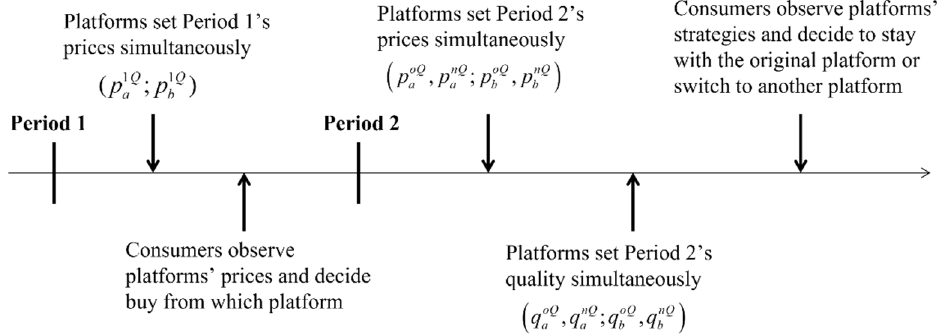
Figure 1. The timing of the main model.